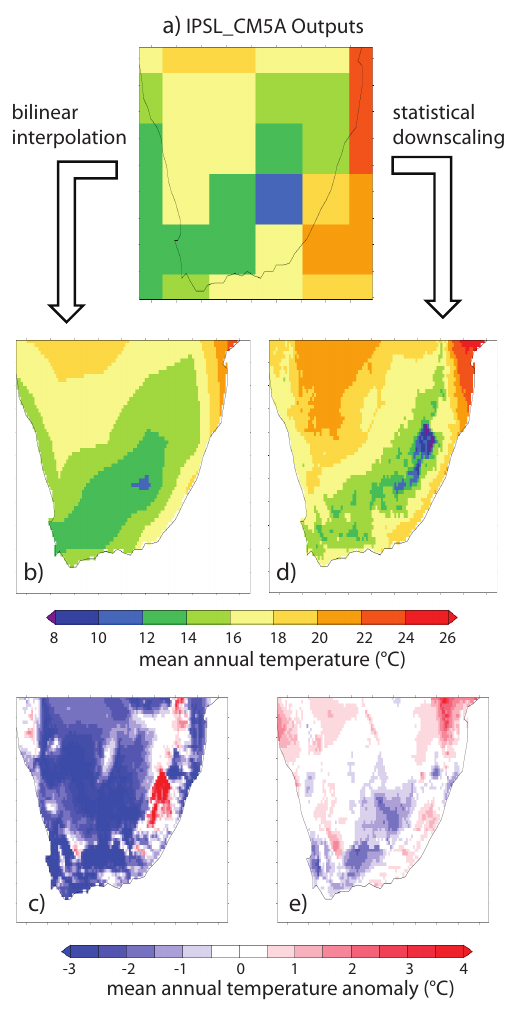
Figure 2. (a) Mean Annual temperature for present day simulated by IPSL_CM5A over southern Africa (average over the years 1960– 1990 from a 20th century simulation). Mean annual temperature simulated by IPSL_CM5A for present day with a spatial resolu- tion increased to 0.16 ◦ through a bilinear interpolation (b) and dif- ference with the CRU data (IPSL_CM5A – CRU) (c) . Mean An- nual temperature simulated by IPSL_CM5A for present day with a spatial resolution increased to 0.16 ◦ through statistical downscaling (d) and difference with the CRU data (IPSL_CM5A – CRU) (e) .